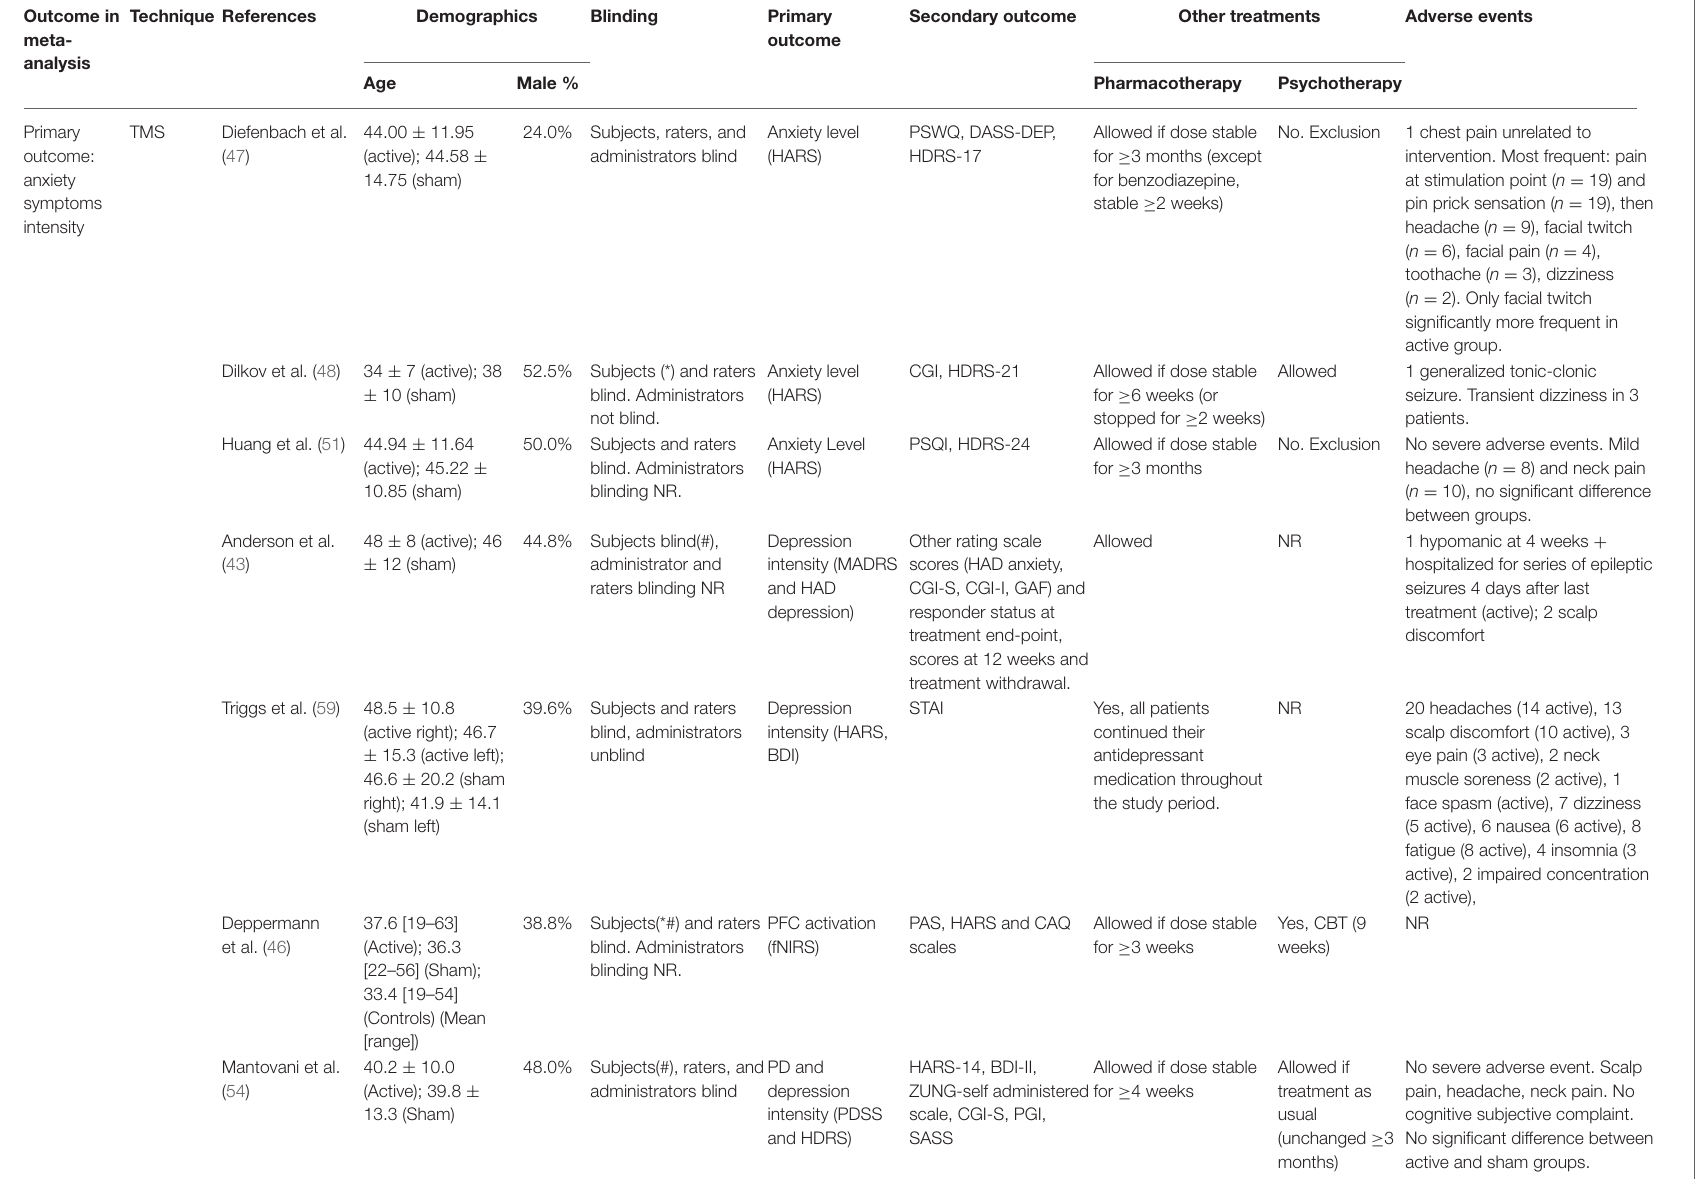
TABLE 3 | Characteristics of included studies (socio-demographic data, blinding protocols, primary and secondary outcomes, other treatments, adverse